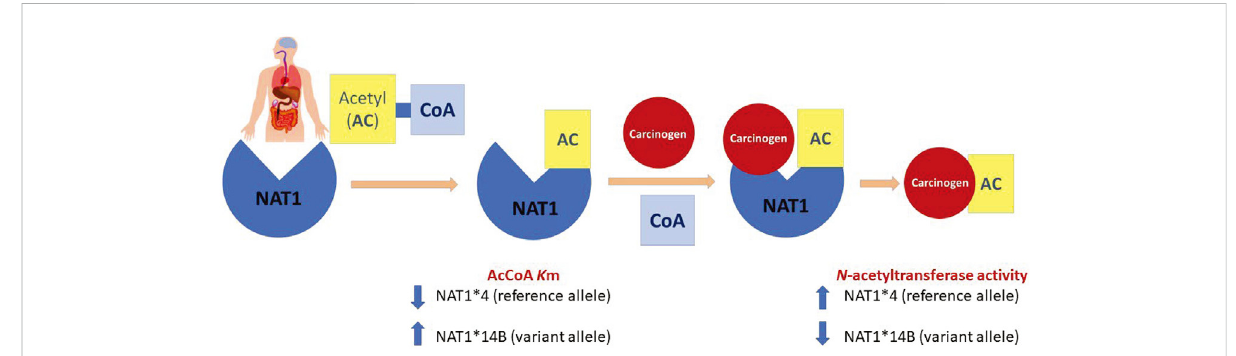
FIGURE 9 N -acetylation of carcinogens via NAT1 acts through a ping-pong bi-bi mechanism that requires two steps. First, AcCoA binds to the enzyme to form the acetylated form which is active. Then, binding of the carcinogen is followed by the release of the acetylated product. Our fi ndings showed that NAT1*4 reference allele has higher N -acetylation compared to the variant allele NAT1*14B . Also, af fi nity of NAT1*4 towards AcCoA was higher than that of NAT1*14B represented by lower Km